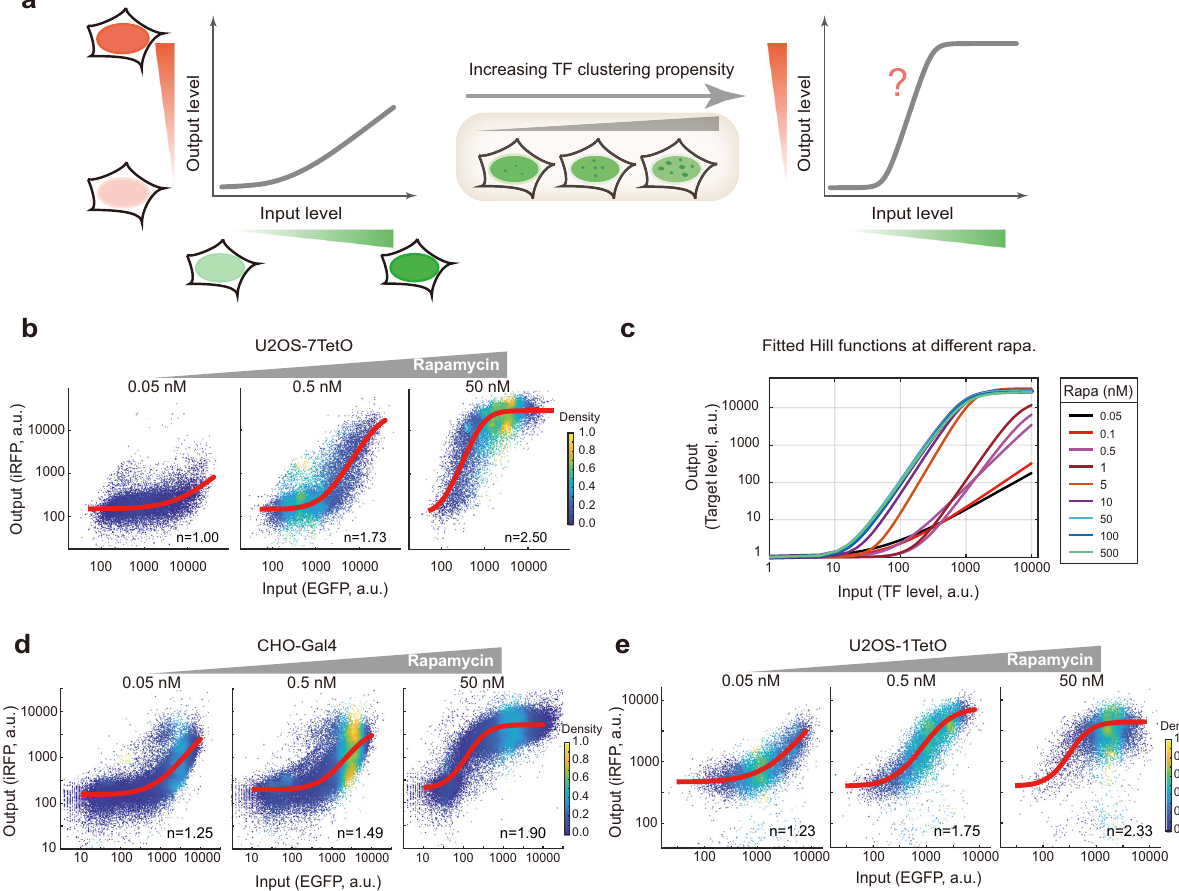
Fig. 4 TF clustering propensity modulates the gene regulation functions of synthetic TFs. a Assay design. b - c , TF clustering propensity modulates the gene regulation function of the U2OS-7TetO system. Steady-state TF (EGFP) and reporter (iRFP) signals (i.e., inputs and outputs) were quanti fi ed by fl ow cytometry at indicated rapamycin concentrations (with 0.3 μ g/mL doxycycline) and were fi tted by Hill function (red curve) ( b ). n indicates fi tted Hill coef fi cient. See also Supplementary Fig. 5d – f for more details. Fitted Hill functions were plotted together to indicate the modulation of both effective binding af fi nity and Hill coef fi cient ( c ). d – e TF clustering propensity also modulates the gene regulation functions in CHO-Gal4 ( d ) and U2OS-1TetO ( e ) systems. Analogous experiments and fi tting as in ( b ) were performed for these two systems (see Methods). See also Supplementary Fig. 6. Source data are